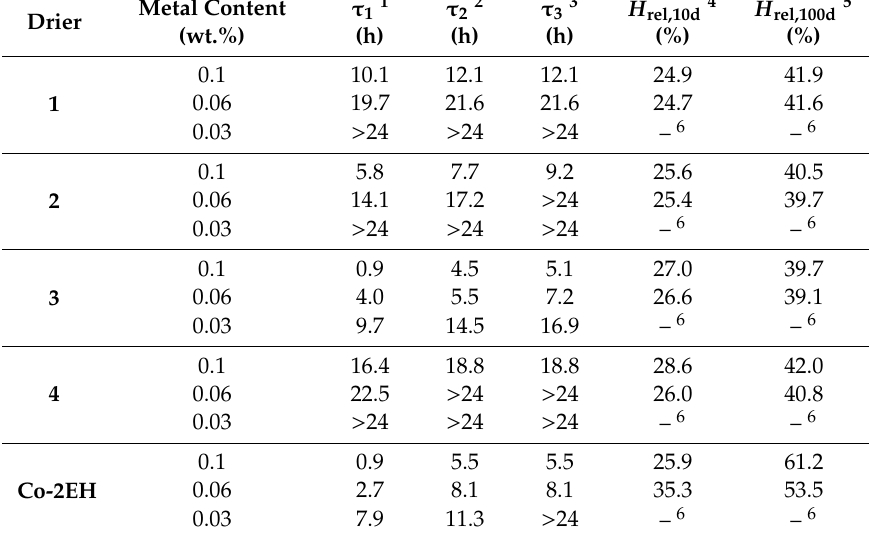
Table 4. Drying times of test coatings and development of their